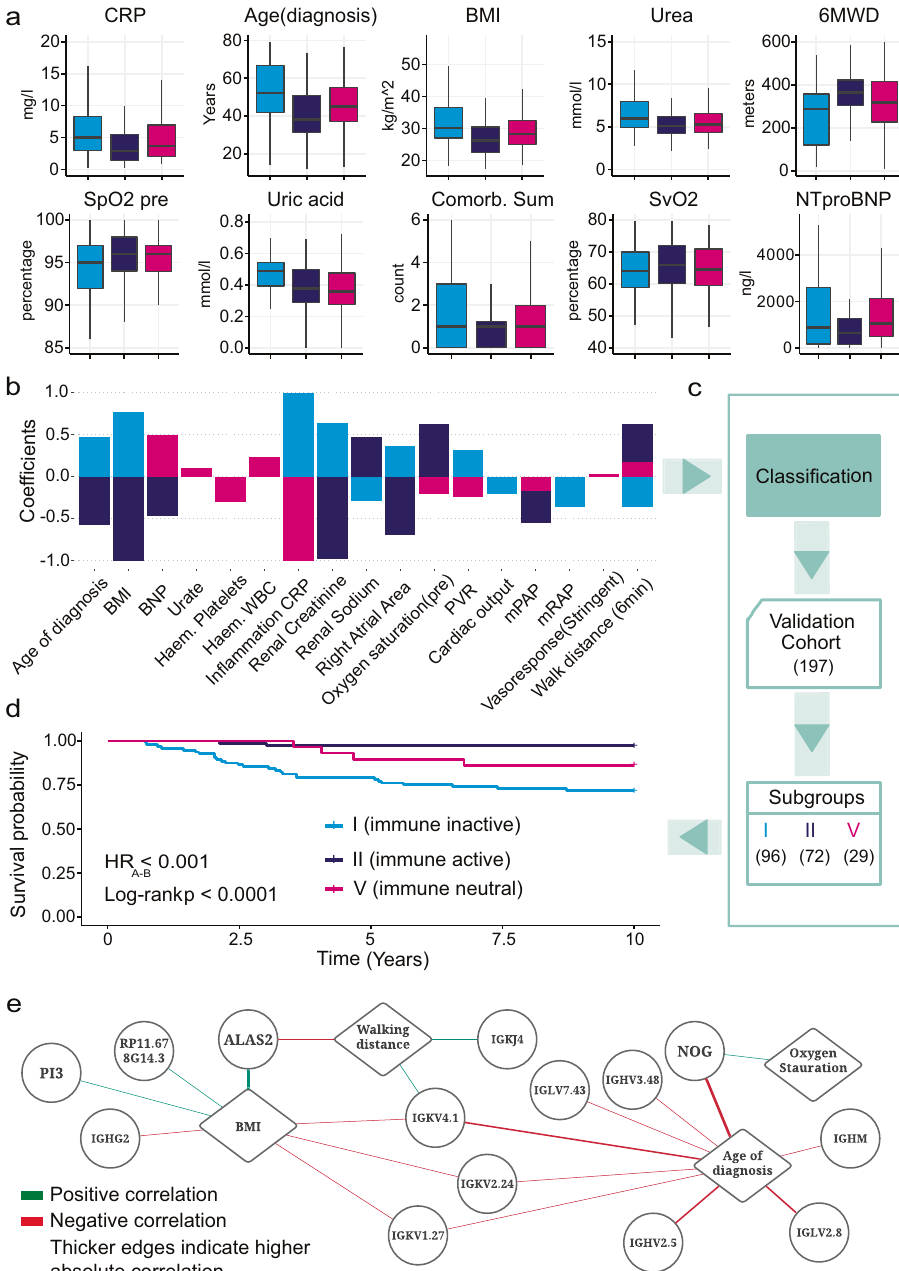
Fig. 5 Clinical variables descriptive of RNA subgroups and used for classi fi cation of new patients. a Comparison of clinical variables deemed most important from our univariate feature selection model across subgroups I ( n = 129), II ( n = 112) and V ( n = 89). Vertical centre line represents the median, top and bottom bounds of the box represent the fi rst and third quartile, while the tips of the whiskers represent min and max values. b Clinical variables selected by ensemble feature selection from models predictive of each subgroup. Coef fi cients shown for each variable are from the most predictive support vector machine classi fi ers. c Selected clinical features are used to classify 197 IPAH patients from an independent validation cohort. d Kaplan – Meier survival curves per predicted subgroup in the validation cohort con fi rming the difference in survival outcomes between subgroups along with log-rank test p values. e Gene and clinical variable correlation network. Diamond nodes represent clinical variables drawn from the clinical signatures. Round nodes represent genes drawn from the gene signature generated by our LASSO model. Edges denoted Spearman rank correlation and have been thresholded to 0.25 and two-tailed test p value < 1.11 × 10 − 5 . Speci fi cally, corr BMI-ALAS2 = 1.27 × 10 − 11 , corr BMI-PI3 = 3.17 × 10 − 6 , corr BMI-IGHG2 = 4.13 × 10 − 6 , corr BMI-RP11.678G14.3 = 8.22 × 10 − 6 , corr BMI-IGKV1.27 = 9.32 × 10 − 6 , corr BMI-IGKV2.24 = 3.09 × 10 − 6 , corr BMI-IGKV4.1 = 9.55 × 10 − 7 , corr 6MWD- = 2.83 × 10 − 6 , corr = 2.08 × 10 − 6 , corr = 7.52 × 10 − 10 , corr = 3.72 × 10 − 10 , corr = 1.06 × 10 − 9 , corr IGKV4.1 6MWD-IGKJ4 6MWD-ALAS2 AoD-IGHV2.5 AoD-IGLV2.8 AoD- = 6.2 × 10 − 8 , corr = 3.18 × 10 − 17 , corr = 7.7 × 10 − 7 , corr = 1.04 × 10 − 6 , corr = 6.35 × 10 − 10 , corr AoD-NOG AoD-IGHV3.48 AoD-IGLV7.43 AoD-IGKV4.1 AoD- IGHM = 4.19 × 10 − 6 , corr = 3.93 × 10 − 7 , corr = 1.11 × 10 − 6 IGKV2.24 AoD-IGKV1.27 OxygenSat-NOG